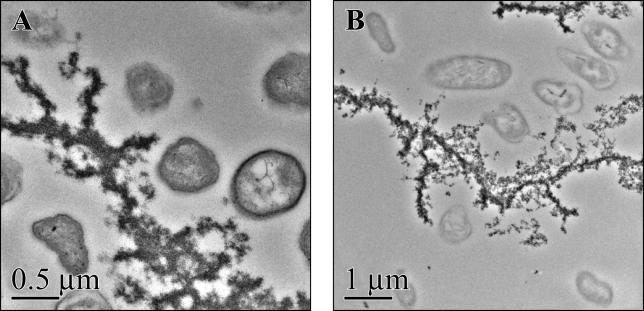
Heme Staining of Extracellular Cytochromes from
S. oneidensis MR-1
TEM images of thin sections of MR-1 incubated for 24 h with 100 μM U(VI) and stained for the presence of heme. Samples were incubated with DAB and developed with H
2O
2 (A) or with DAB but not developed with H
2O
2 (B) prior to embedding. Heme-containing proteins detected in (A) were shown in close association with the undeveloped UO
2-EPS seen in (B).